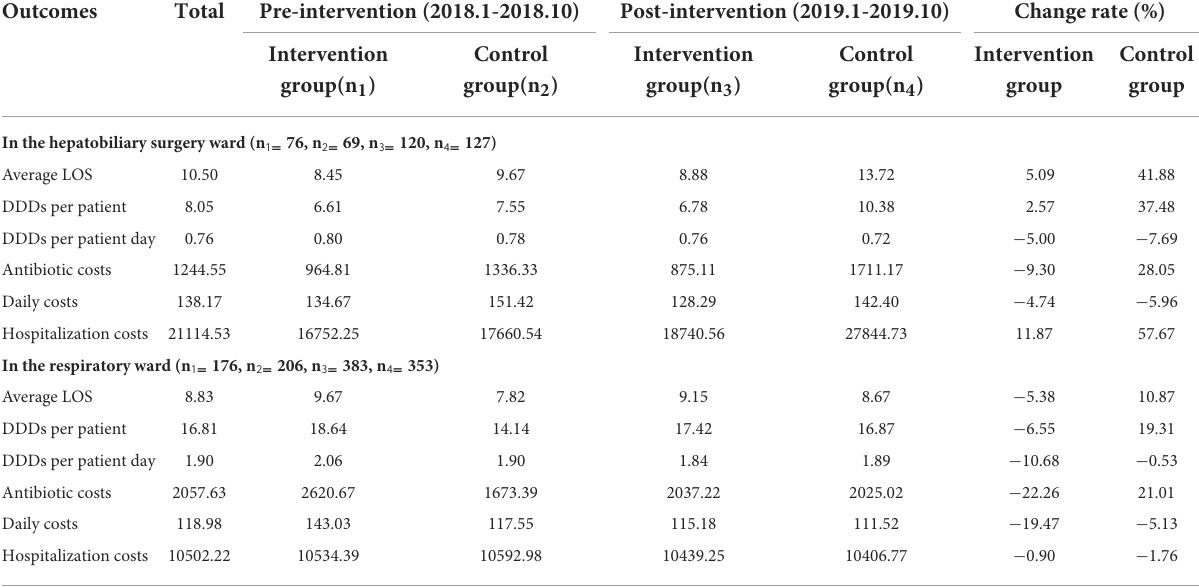
TABLE 3 Mean of the consumption and costs of antibiotics and LOS in two wards.